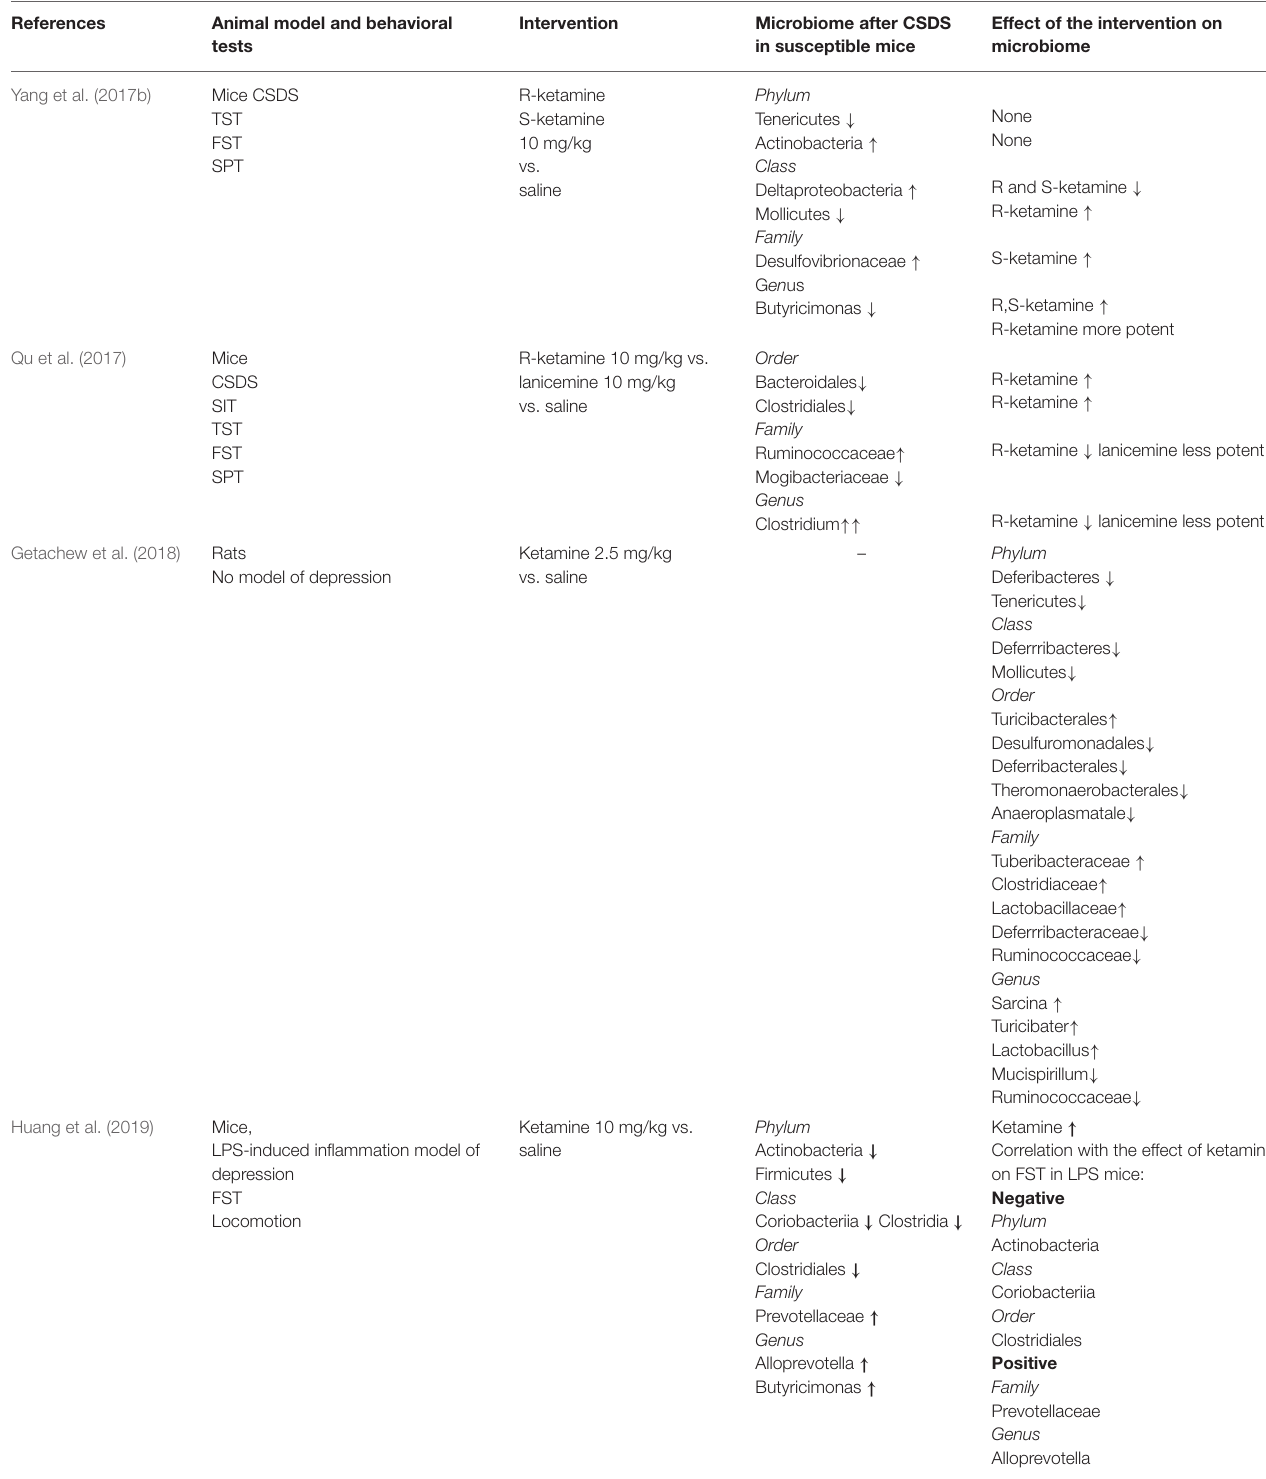
TABLE 1 | Studies on ketamine’s effect on gut microbiota in rodent model of